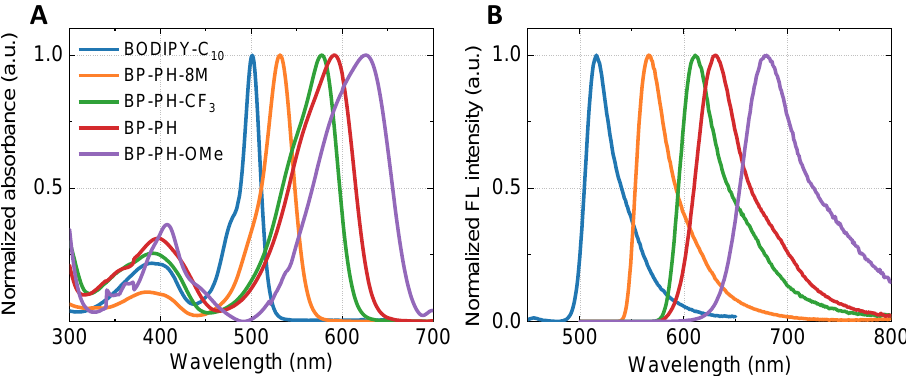
Figure 2. Absorbance ( A ) and fluorescence emission ( B ) spectra of BODIPY-C 10 (blue), BP-PH-8M (orange), BP-PH-CF 3 (green), BP-PH (red), and BP-PH-OMe (purple).